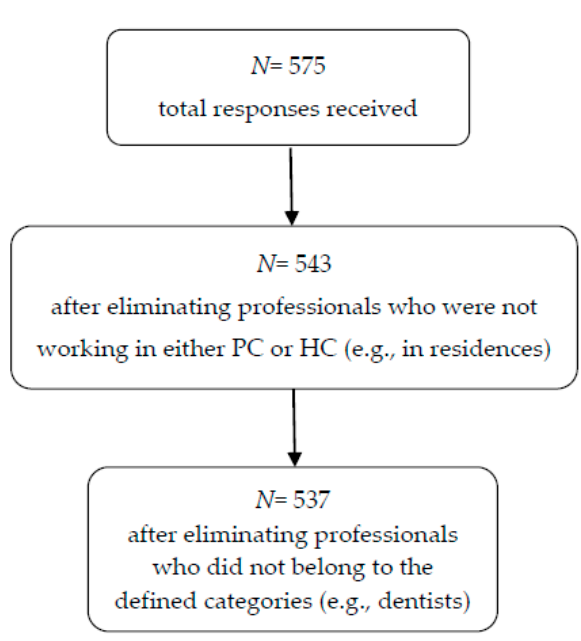
Figure 1. Flowchart of professionals included in the study.